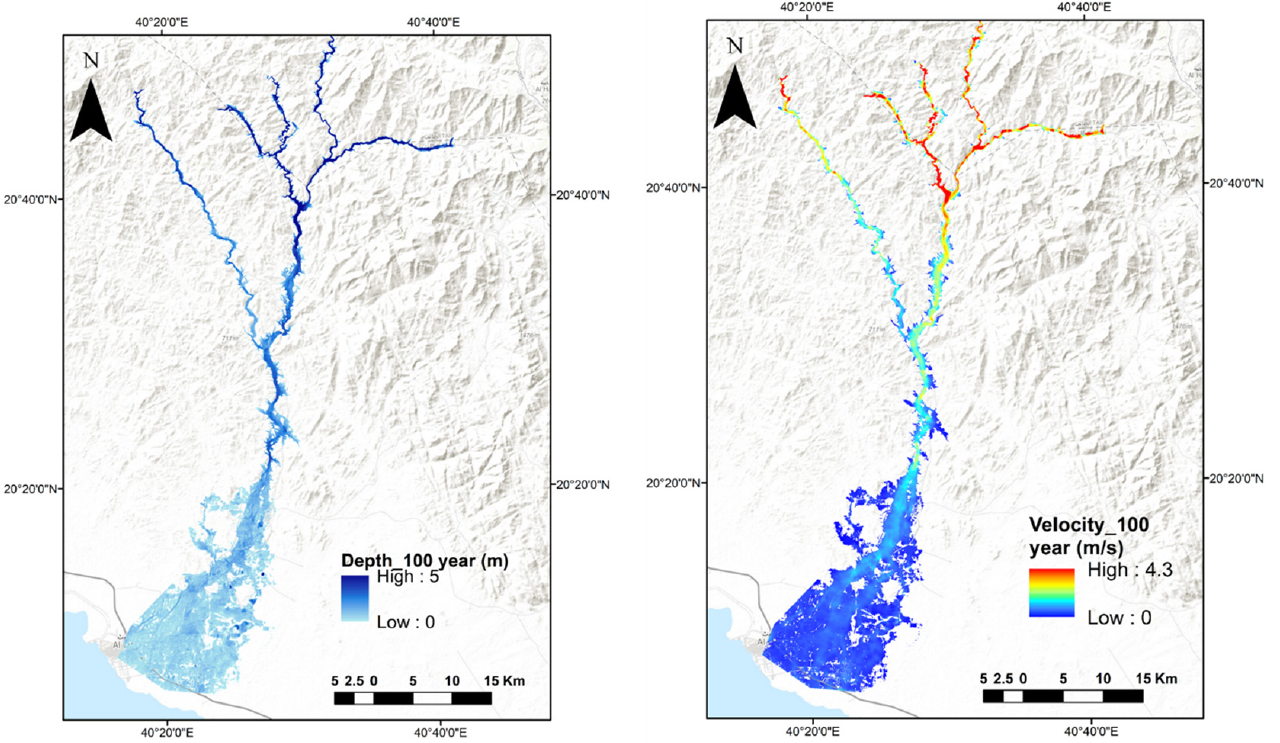
Figure 8. Flood water velocity and depth map of the Al-Lith Valley Basin impacting Al-Lith City in 2018.